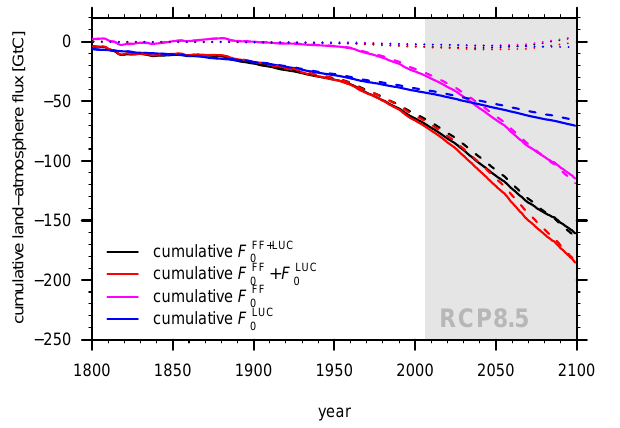
Figure 1. Global cumulative net land-to-atmosphere CO 2 fluxes in- duced by environmental change caused by FF ( F FF ), LUC ( F LUC ), 0 0 their combined effect ( F FF + LUC ), and the sum of individual effects 0 + F LUC ( F FF ). Curves represent cumulative global fluxes induced 0 0 by environmental change, weighted by their time-varying area of natural vegetation (dashed lines), croplands and pastures land (dot- ted lines), and their sum (solid lines). Note that this excludes all direct effects of LUC. The differences between the combined and the sum of effects correspond to the synergy terms δ , following Stein and Alpert (1993). The model setups are described in Tables 1 and